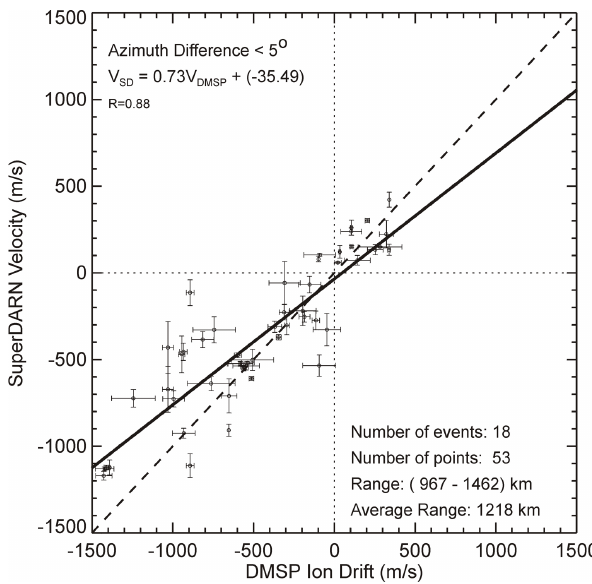
Fig. 5. A scatter plot of the Stokkseyri l-o-s velocity versus the DMSP cross-track ion drift for 18 joint events at radar ranges of ∼ 1000–1500km.